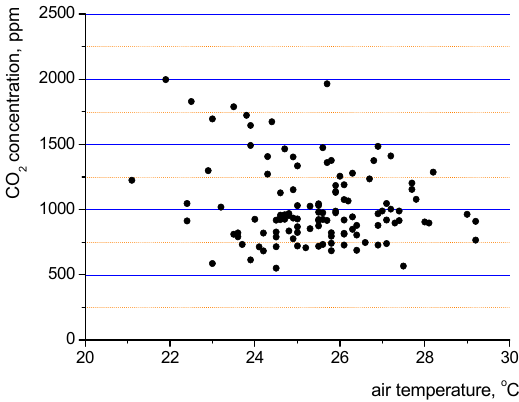
Figure 7. Indoor air temperature and carbon dioxide concentration in selected rooms between February 2017 and July 2018.